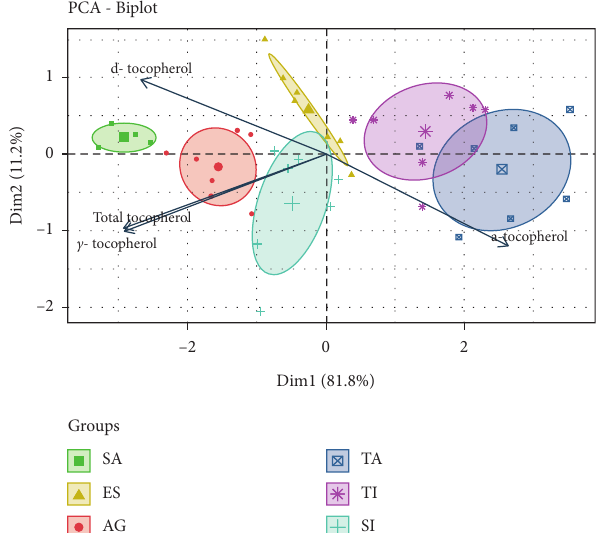
Figure 4: Principal component analysis (PCA) on the tocopherols amount of 39 samples from six different provenances (SA: Safi, ES: Essaouira, AG: Agadir, SI: Sidi Ifni, TA: Taroudant, and TI: Tiznit).